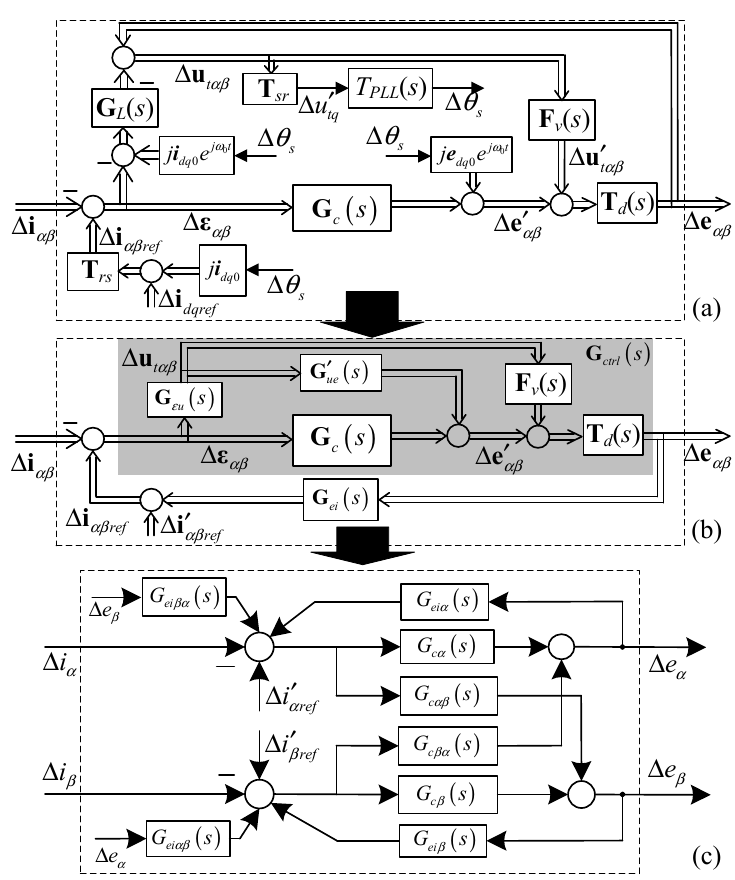
Figure 4. The process to obtain the current-balancing driven internal voltage motion model of VSC with PLL dynamic, ( a ) the VSC model with the linearized coordinate transformation; ( b ) the VSC frequency domain model in a stationary frame; and ( c ) the internal voltage motion model.